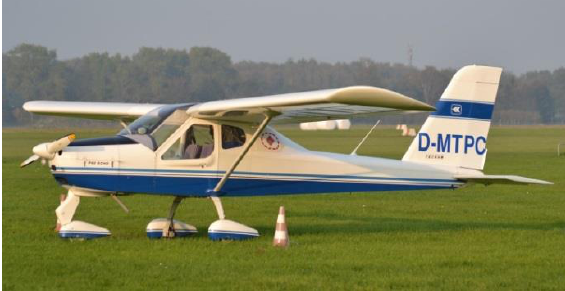
Figure 1. The semiautonomous P92 Tecnam aircraft.